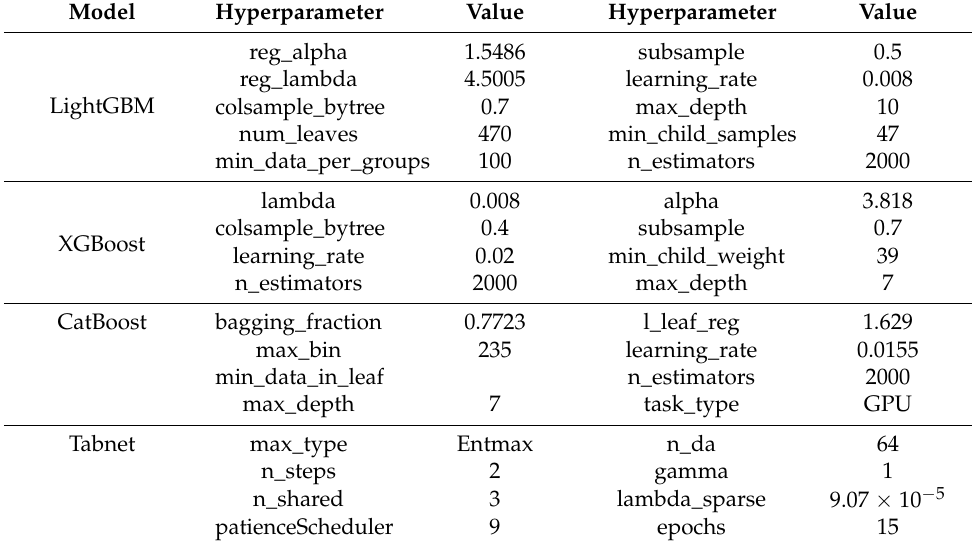
Table A3. Table of hyperparameters for each ML